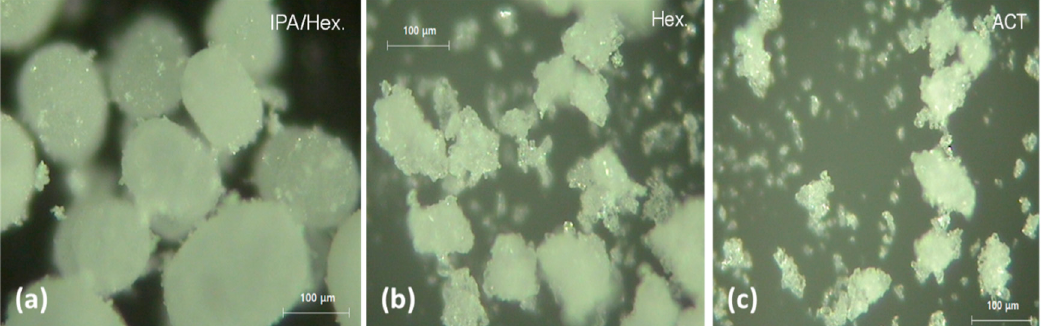
Figure 2. Video-microscopic images of CLP crystals crystallized when ( a ) IPA/Hex [40:60, v/v], ( b ) Hex, and ( c ) ACT were used as anti-solvents.